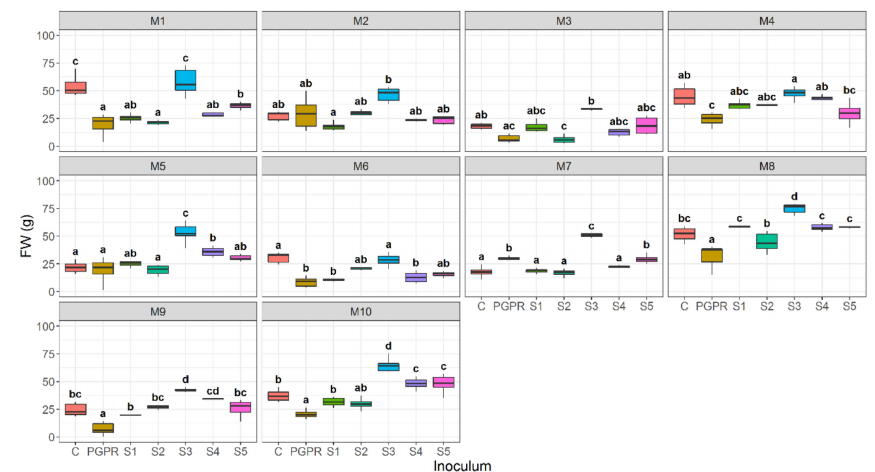
Figure 1. Boxplot of shoot fresh weight (FW; g) grouped per plant growing medium. Letters show comparison of BCI means per plant growing medium at the 95% confidence level. S indicates the bacterial community inoculum, M indicates the plant growing medium, C indicates the negative control treatment without addition of inoculum, and PGPR indicates the positive control treatment with a Bacillus sp. inoculum. Number of plants ≥